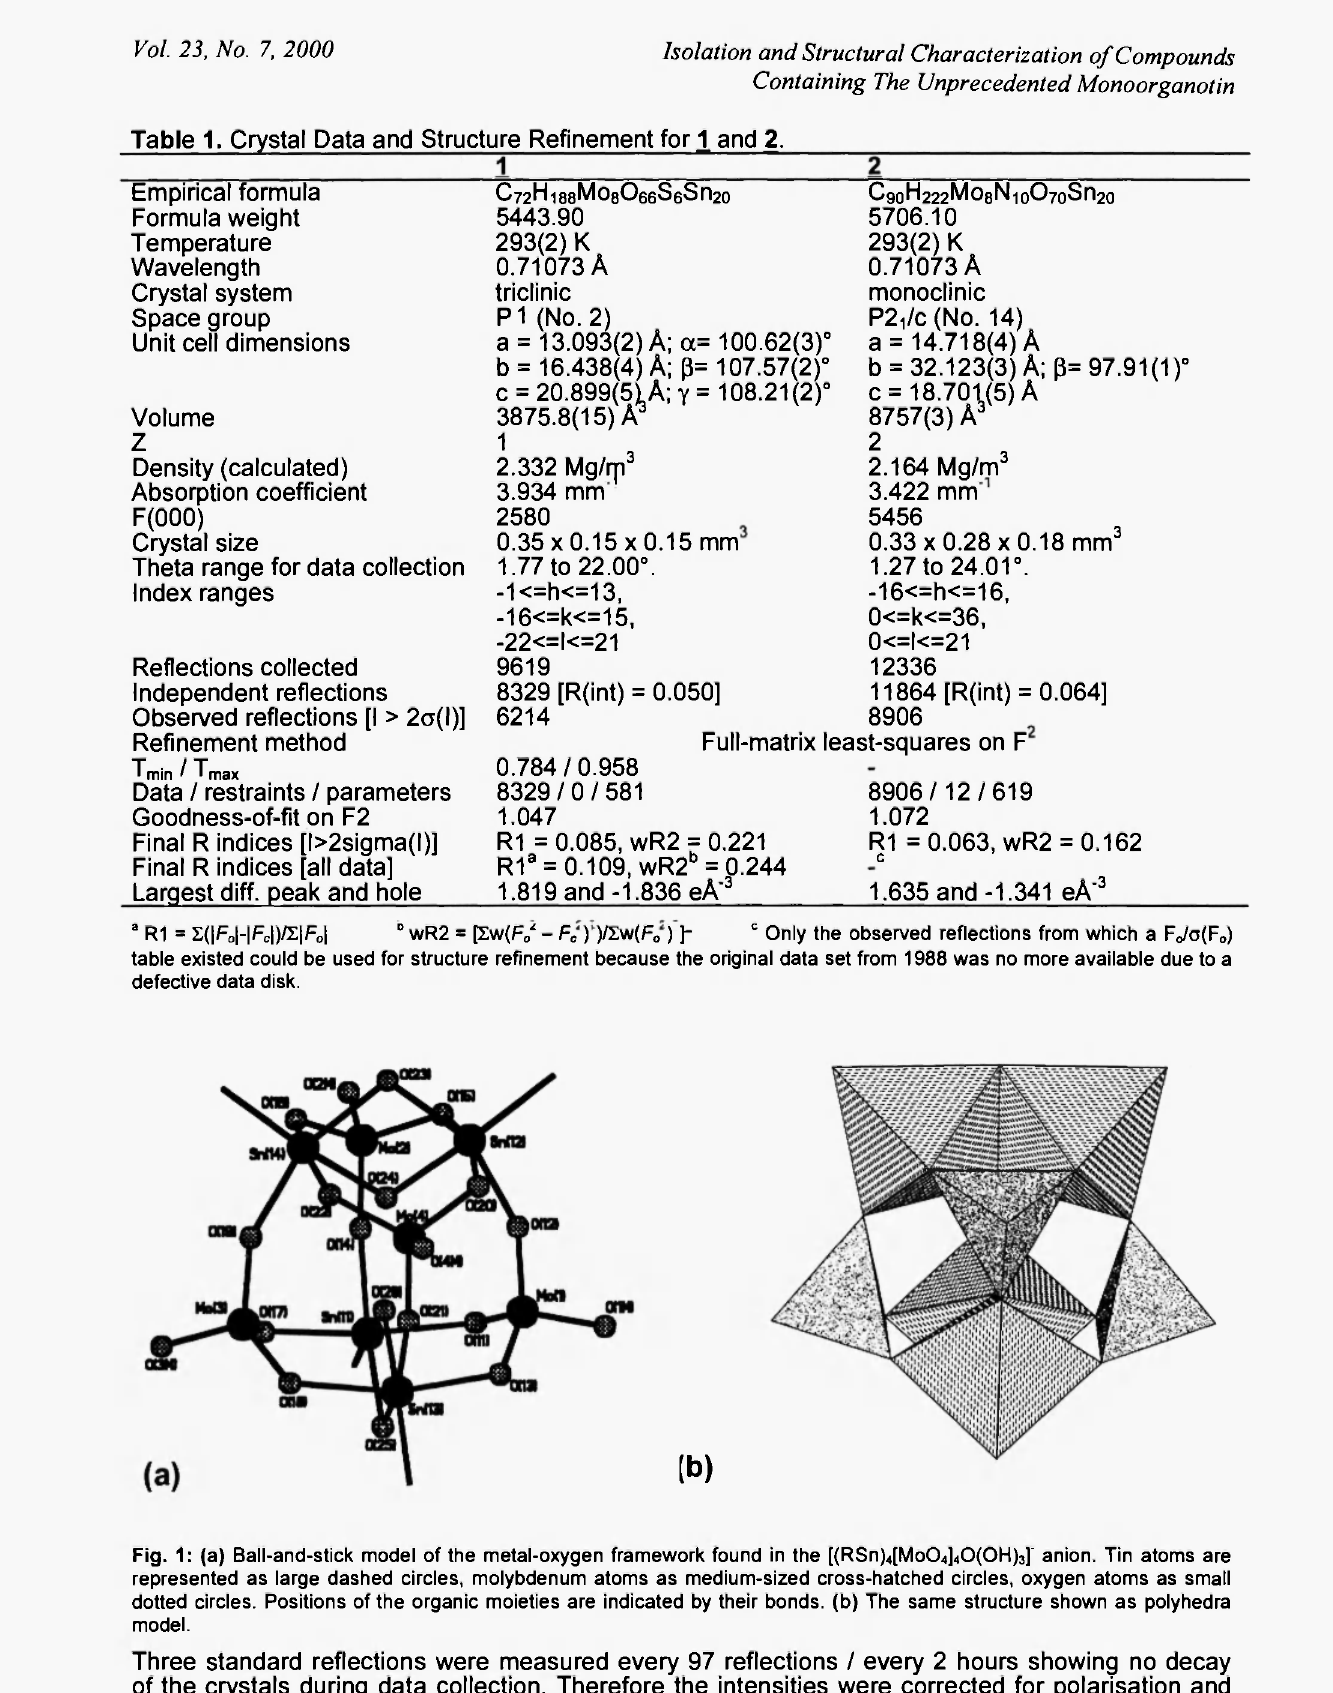
Fig. 1: (a) Ball-and-stick model of the metal-oxygen framework found in the [(RSn) 4 [Mo04iC>(OH)3]~ anion. Tin atoms are represented as large dashed circles, molybdenum atoms as medium-sized cross-hatched circles, oxygen atoms as small dotted circles. Positions of the organic moieties are indicated by their bonds, (b) The same structure shown as polyhedra model. Three standard reflections were measured every 97 reflections / every 2 hours showing no decay of the crystals during data collection. Therefore the intensities were corrected for polarisation